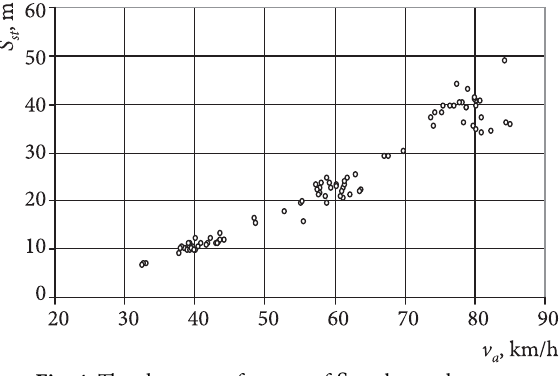
Fig. 4. Th e character of scatter of S values, when cars st without/with ABS are evaluated